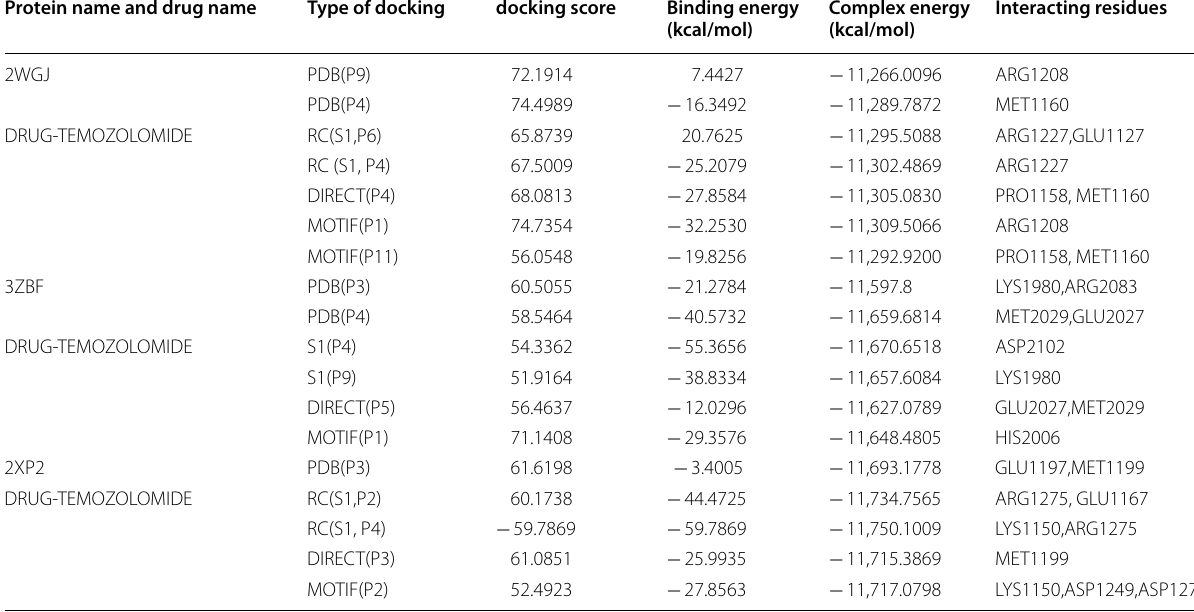
Table 5 The details of the druggable binding site, their docking score and binding energy, least complex energy and the main interaction showed amino acid residues at the binding site Protein name and drug